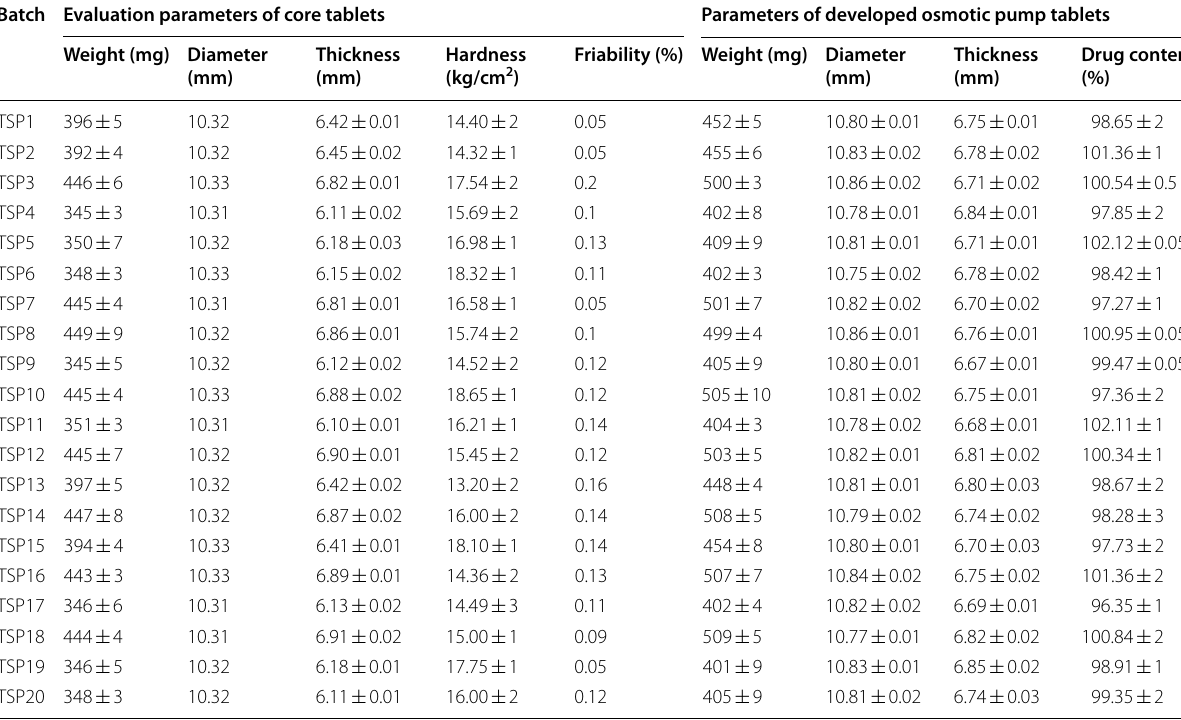
Values are expressed as mean